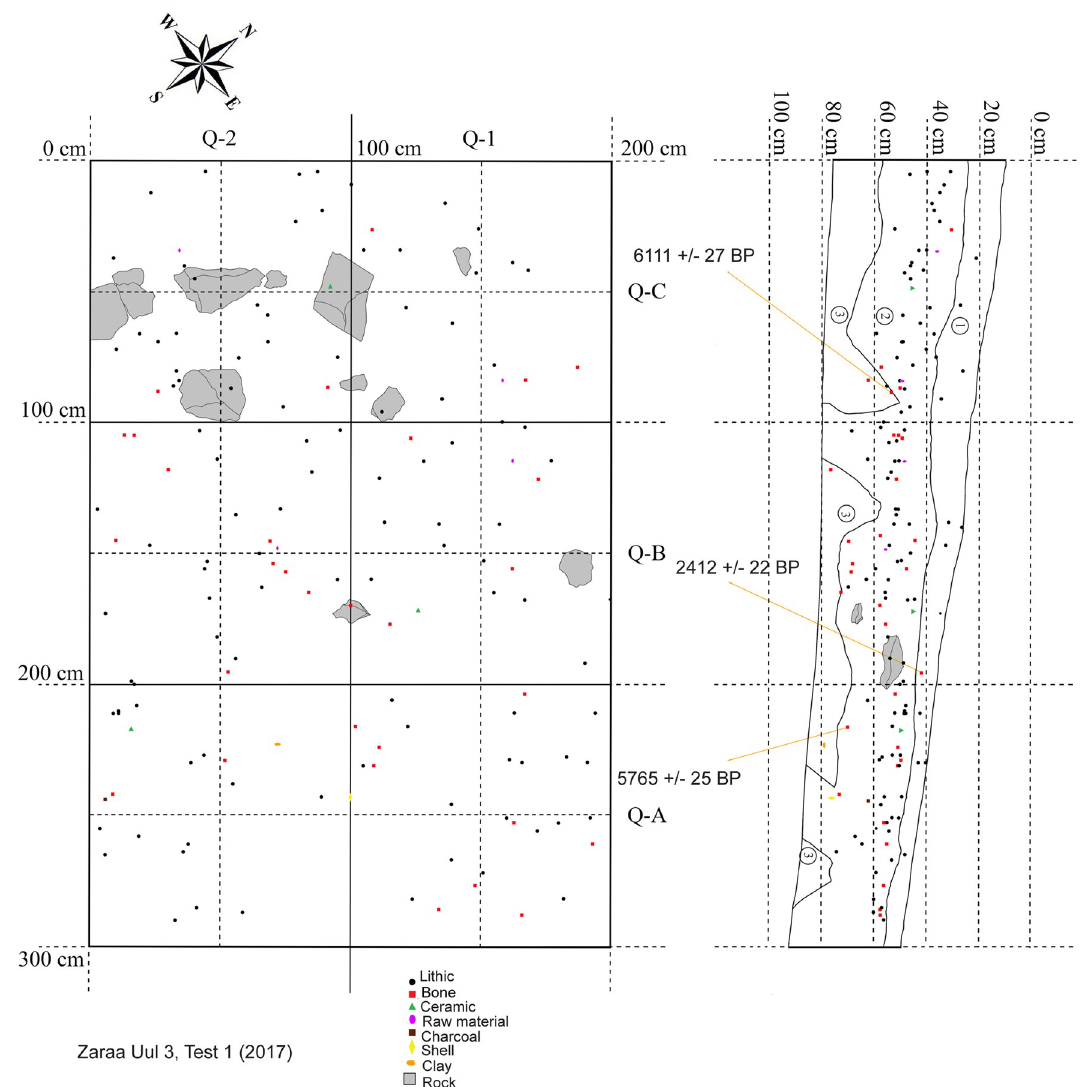
Fig 6. Map of 2017 excavation at Zaraa Uul, Locus 3 (ZU3.T1).